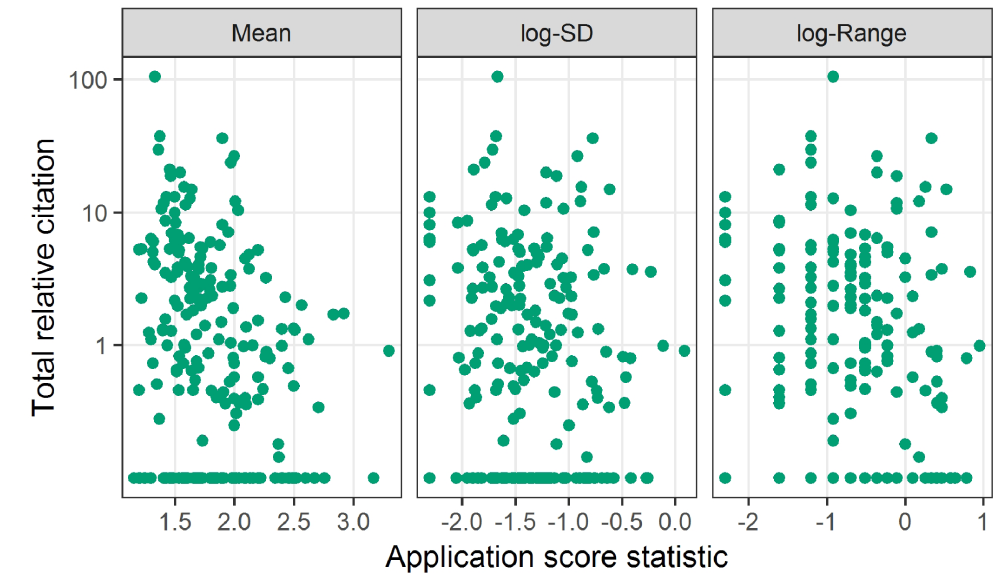
Figure 3. Scatter-plots of log-transformed total relative citations against application score